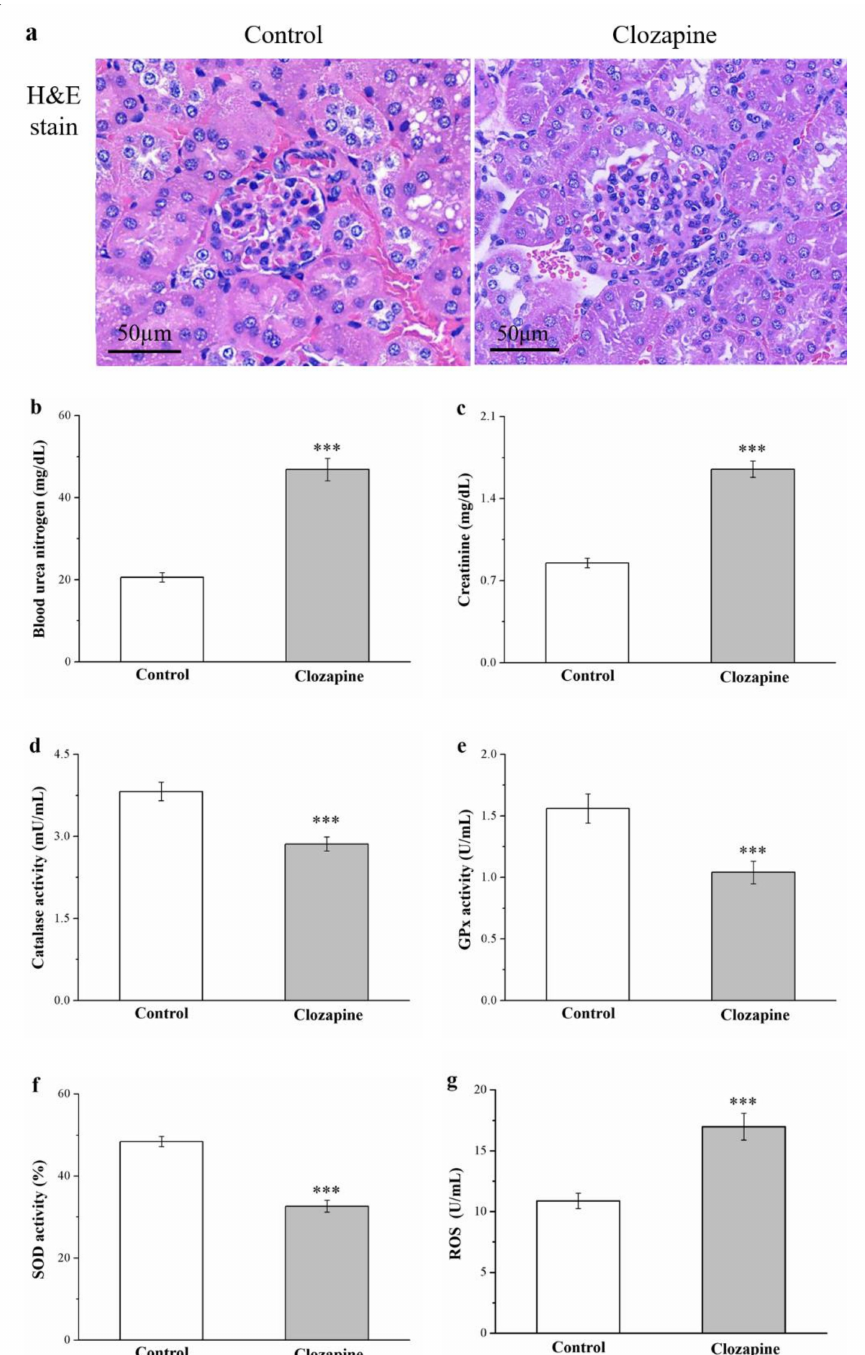
Figure 8. ( a ) Hematoxylin and eosin (H&E) stains showing differing renal morphology (magnification, 200 × ); serum levels of ( b ) blood urea nitrogen and ( c ) creatinine; ( d ) renal catalase activity; ( e ) renal glutathione peroxidase (GPx) activity; ( f ) renal superoxide dismutase (SOD) activity; and ( g ) renal reactive oxygen species (ROS) in the clozapine (receiving 2 mg/kg/day) and control groups. Data are mean ± standard deviation ( n = 10). *** p <